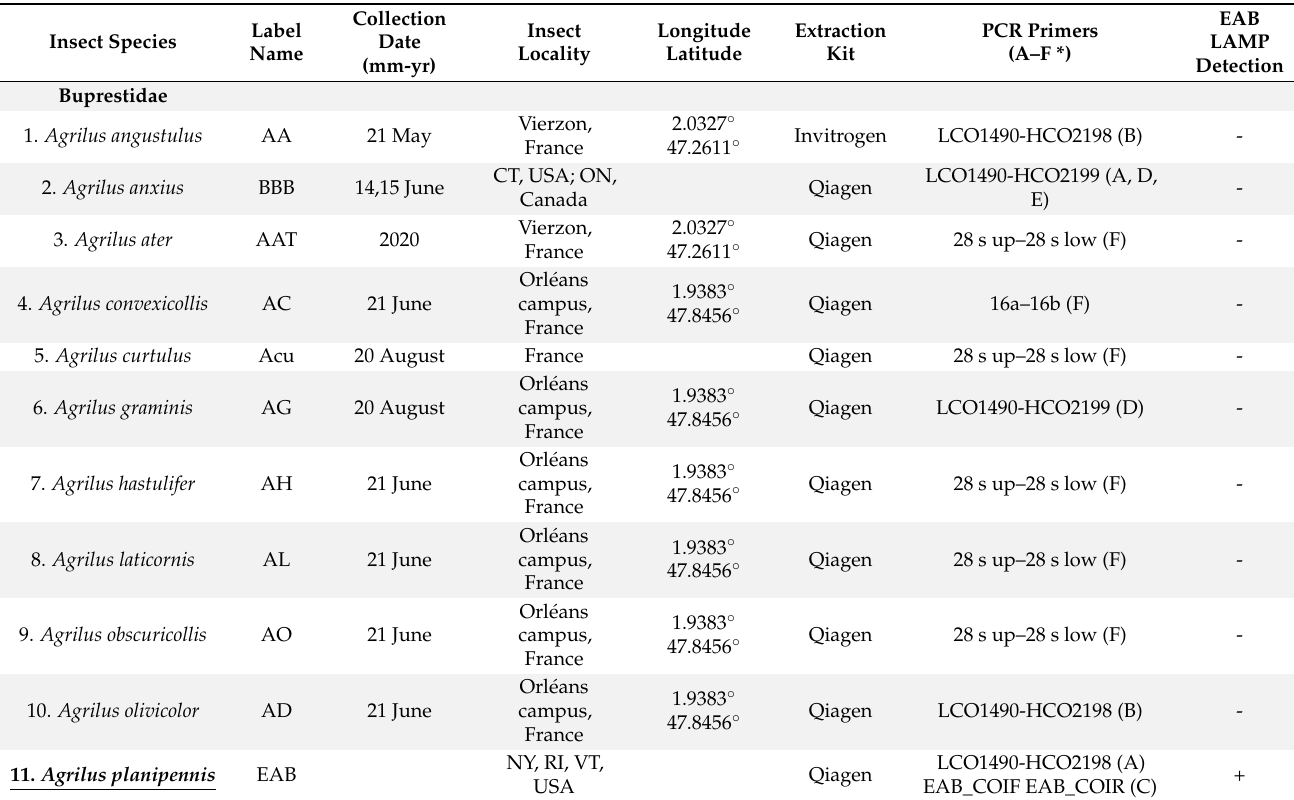
Table 1. Insect species used for specificity testing for EAB LAMP primers for use in European conditions including insect collection location, collection date, and the DNA extraction kit and